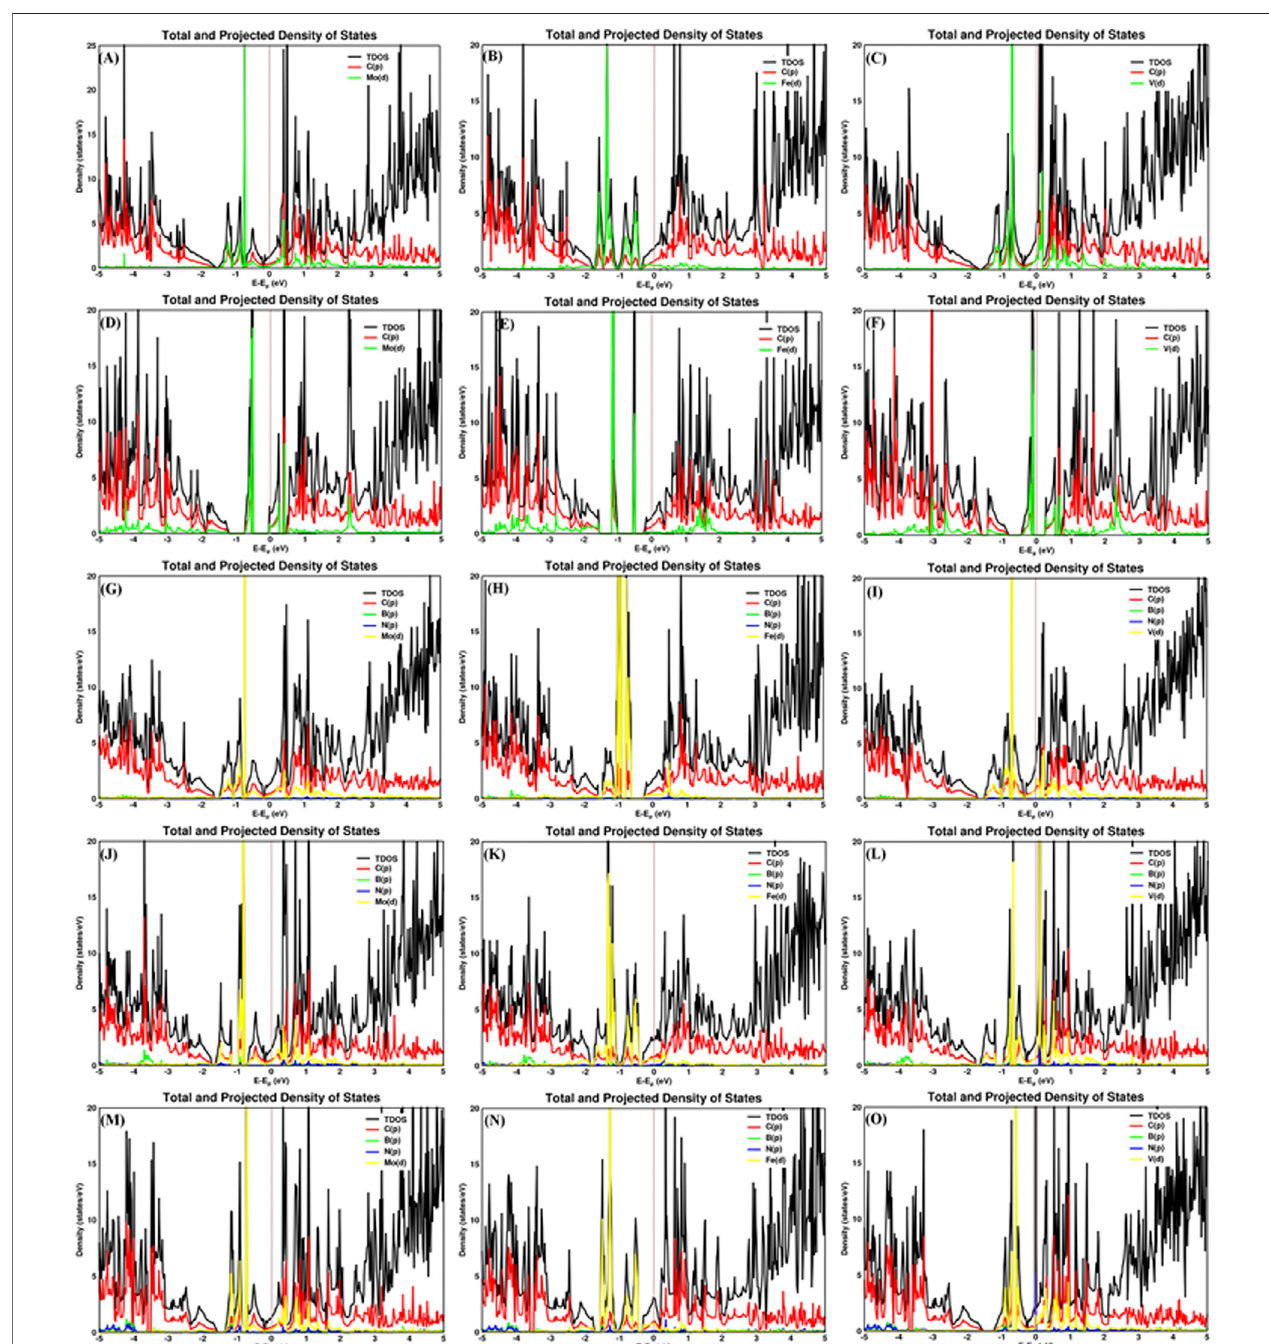
FIGURE 3 | Total and projected density of states of Mo, Fe, and V on (A – C) pristine graphene, (D – F) defective graphene, (G – I) BN-doped graphene, (J – L) BNC- ring graphene, and (M – O) BN-ring graphene.